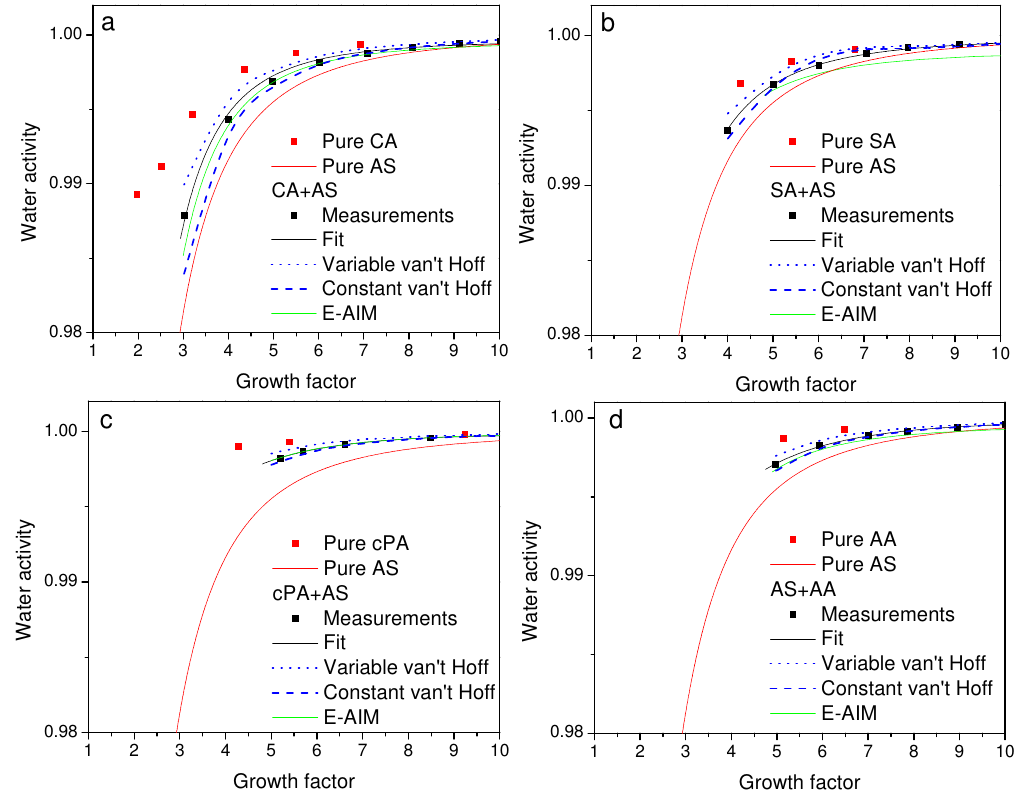
Fig. 5. Water activity of four of the studied 50:50 mixtures (abbreviations are explained in Table 1). The data for pure acids is obtained from Varga et al. (2007). Also shown are water activity determined from the E-AIM and calculated using estimated van’t Hoff factors (see Eq. 4). The van’t Hoff factors of the individual compounds are either dependent on solute concentrations (using Eq. (5) for organic acids, and the data of Low (1969) and Young and Warren, (1992) for ammonium sulphate) or assumed to be constant ( i = 1 for the organic acids, and i = 3 for ammonium sulphate).